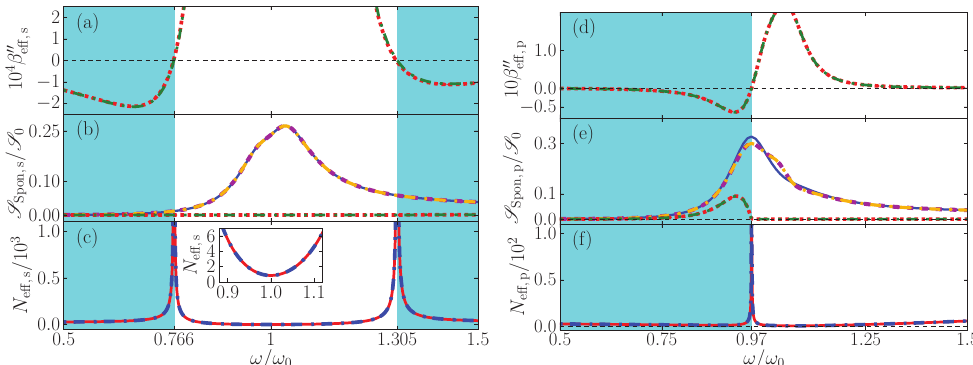
Figure 4. As in Figure 3 but now for light emission at an angle of 60 degrees with respect to the